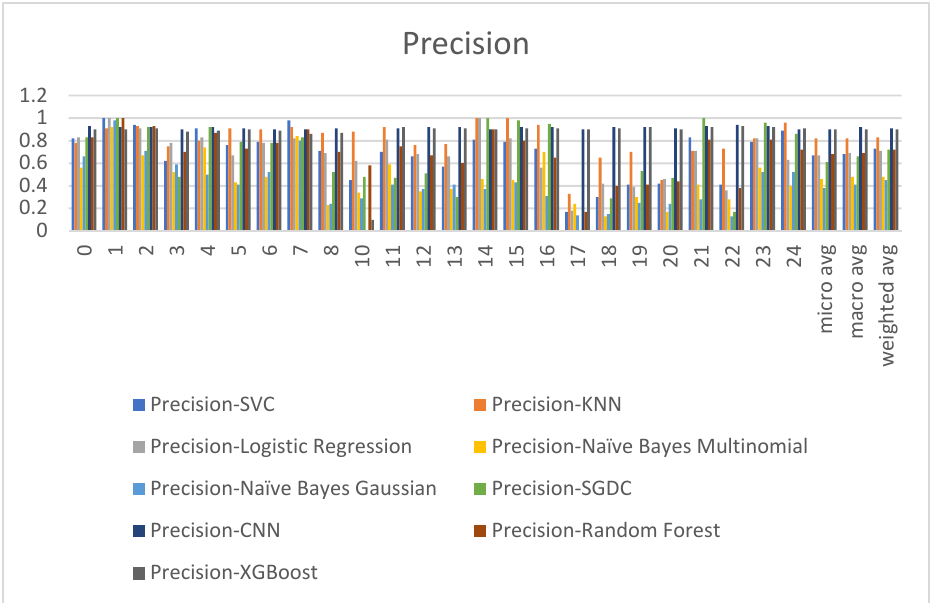
Figure 4. Precision.